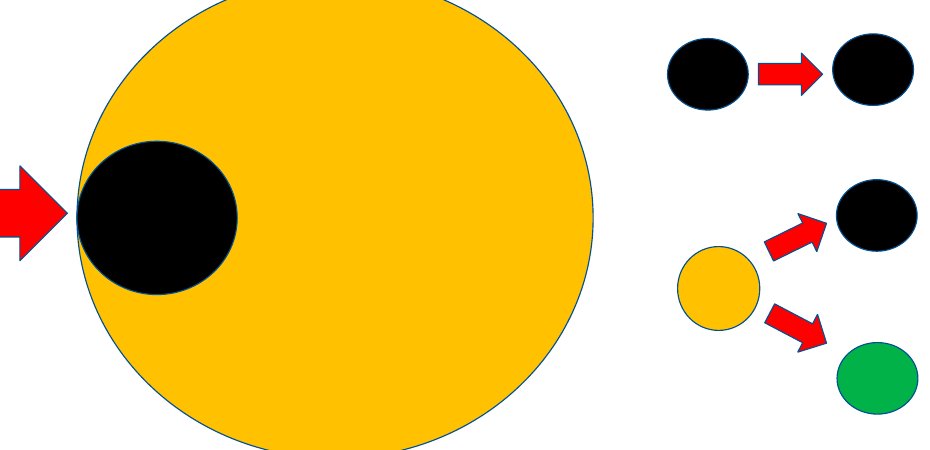
Figure 1. Schematic illustration of the effect of IR damage. As a result of ischemia, some of the cells are primarily irreversibly damaged; they can no longer be influenced therapeutically. Reversibly damaged cells can be influenced. The next approach can lead to their recovery or to irreversible necrosis. Explanations: the yellow circle with the black one inside represents all cells that experienced ischemia, the yellow circle represents the cells with reversible damage, the black circle represents the dead cells (irreversible damage), and the green circle represents the surviving viable cells.